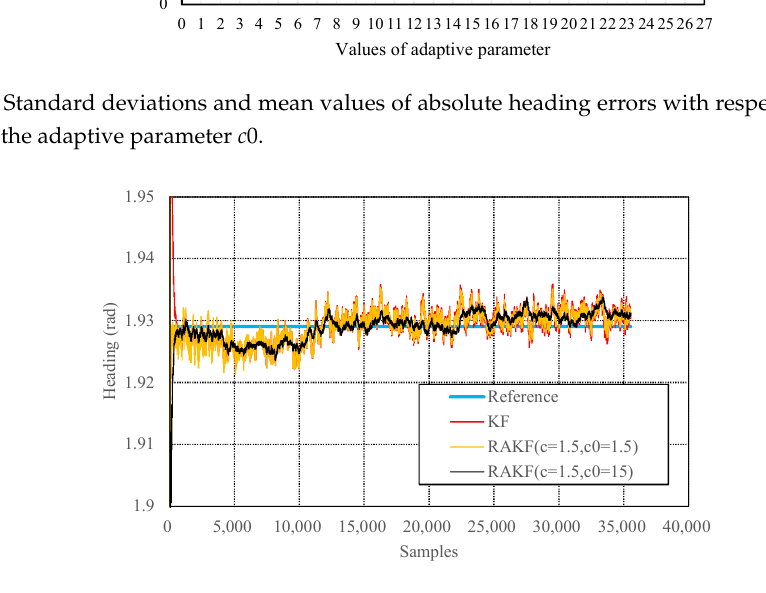
Figure 6. Comparisons of the performances on heading estimation of different algorithms in the static test. Table 2. Statistical results of estimation errors of EKF and RAEKF.